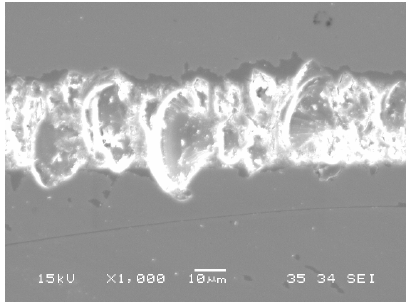
Figure 9. SEM micrographs of cutting grooves for fused silica